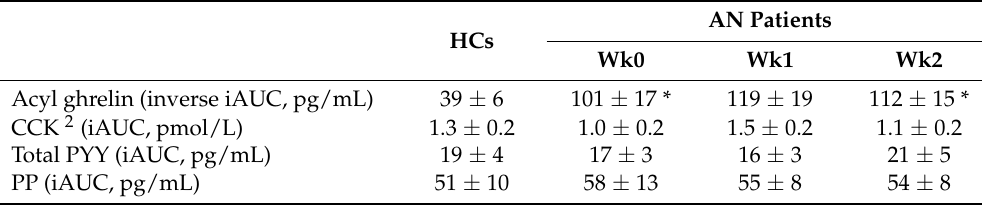
Table 4. Inverse incremental area under the curves (iAUCs) per minute for acyl ghrelin, and iAUCs per minute for CCK, total PYY and PP 1